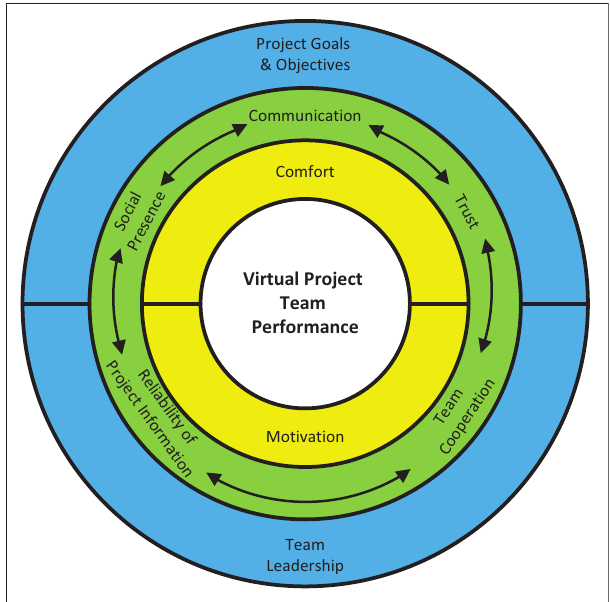
FIGURE 1: A conceptual model for improving performance in virtual project